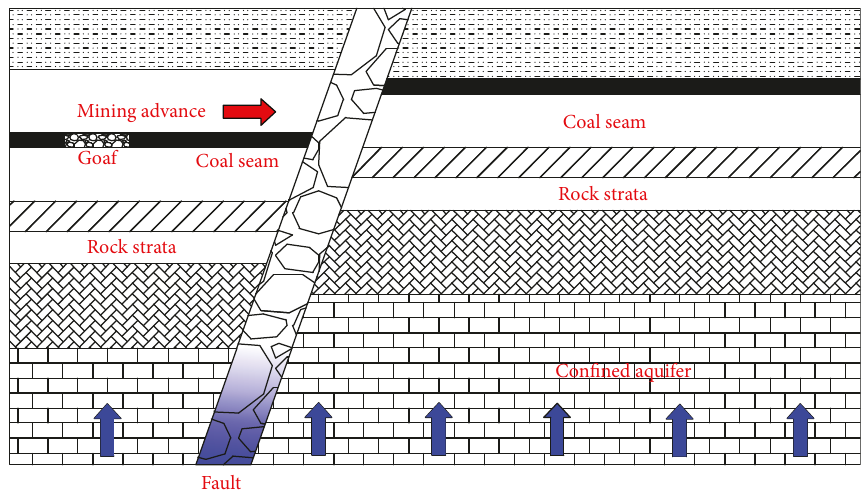
Figure 1: Diagram of a fault: di ff erent shapes of rock strata represent di ff erent types of rocks.